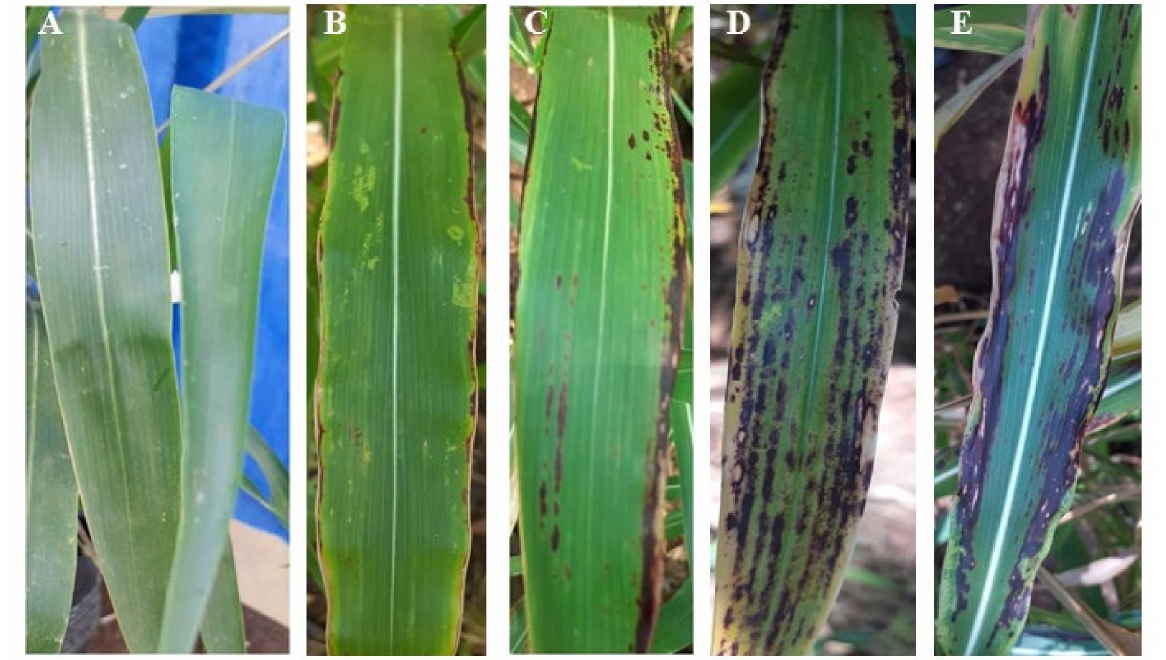
Figure 3. Reaction of sorghum genotypes to Colletotrichumsublineolum inoculation under greenhouse conditions. ( A ) represents the non-inoculated control, ( B ) moderately resistant with presence of yellow flecks with 1–10% of the leaves having necrotic lesion without acervulus, ( C ) moderately susceptible with 1–30% of leaves having necrotic lesions and few acervulus and ( D , E ) susceptible with 1–50% of leaves having necrotic lesions and more acervuli